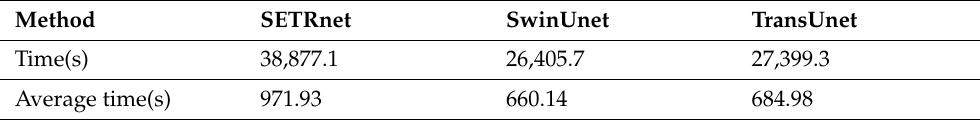
Table 2. Training time of the Potsdam data set.